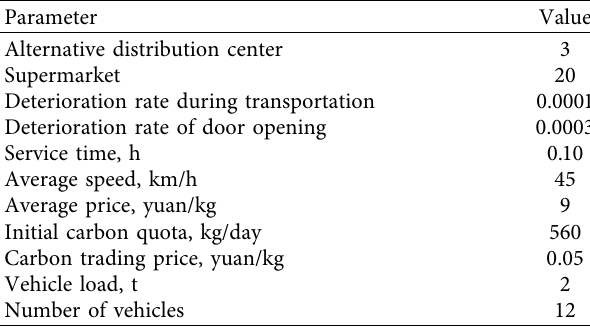
Table 4: Parameter setting.